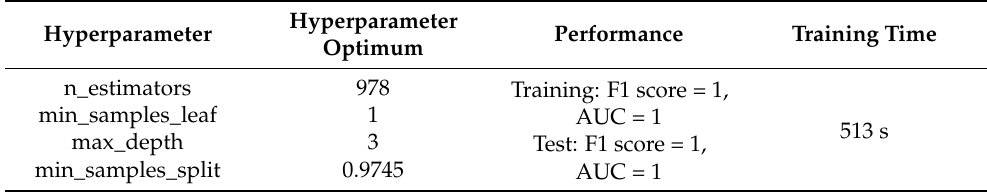
Table 6. The BO results in the GBDT